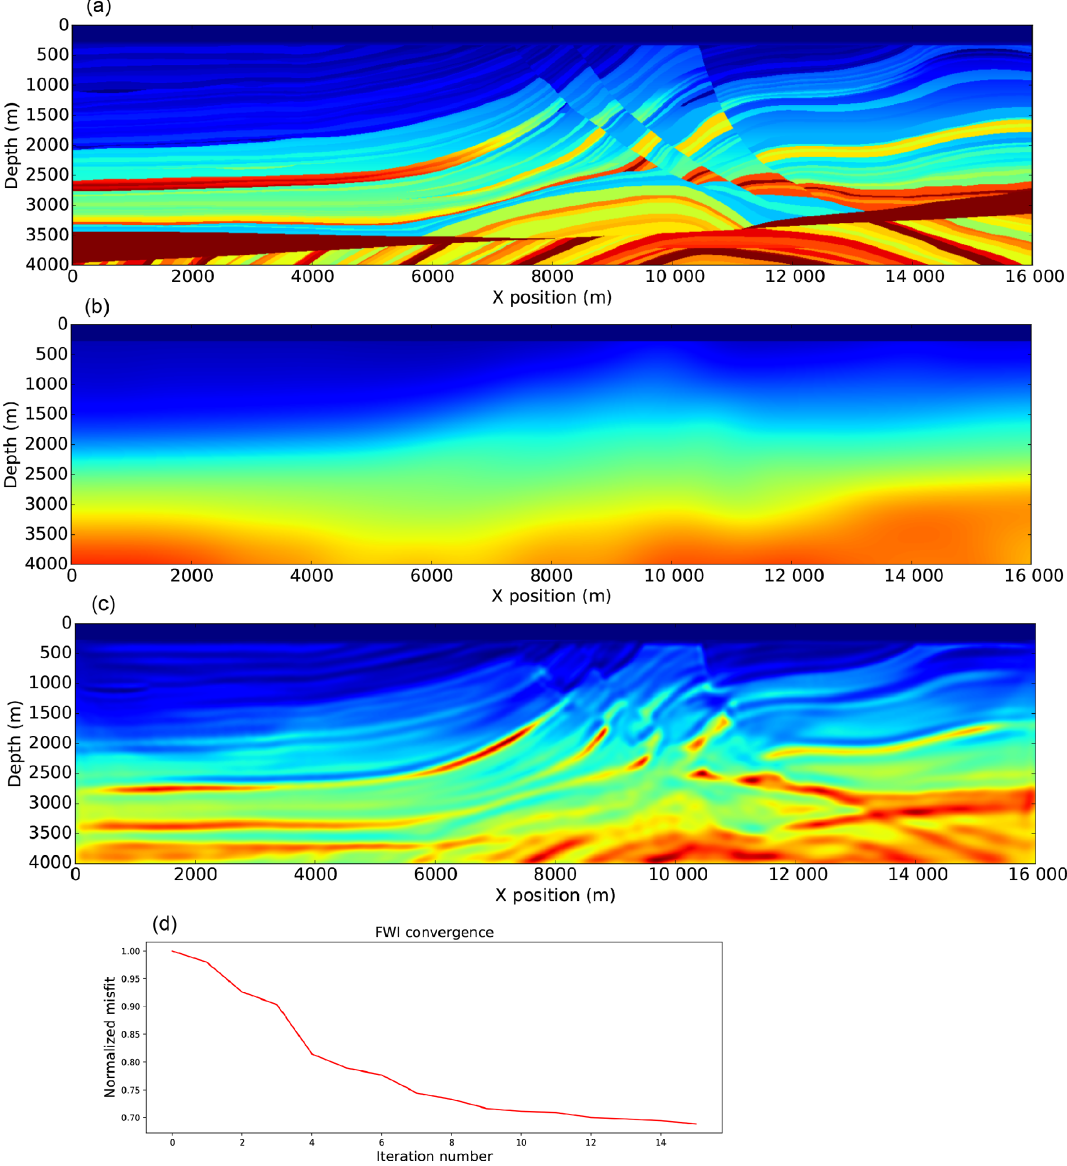
Figure 13. FWI on the acoustic Marmousi-ii model. Panel (a) is the true velocity model, panel (b) is the initial velocity model, panel (c) is the inverted velocity at the last iteration of the iterative inversion, and panel (d) is the